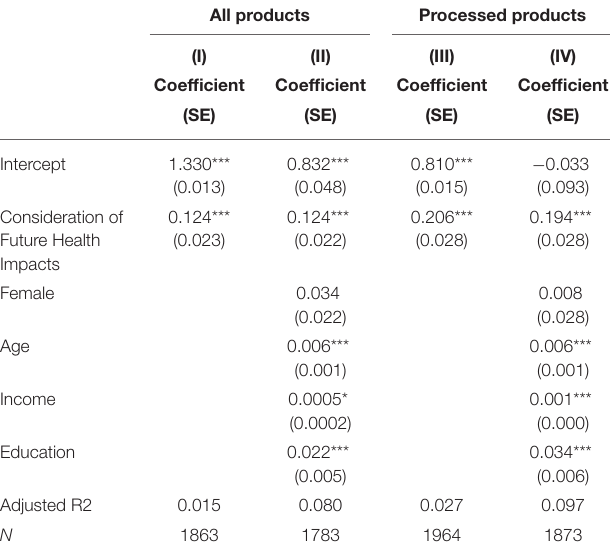
TABLE 3 | Impact of future consideration of health on nutritional quality-based rank of the set of products participants chose to view in the control condition. All